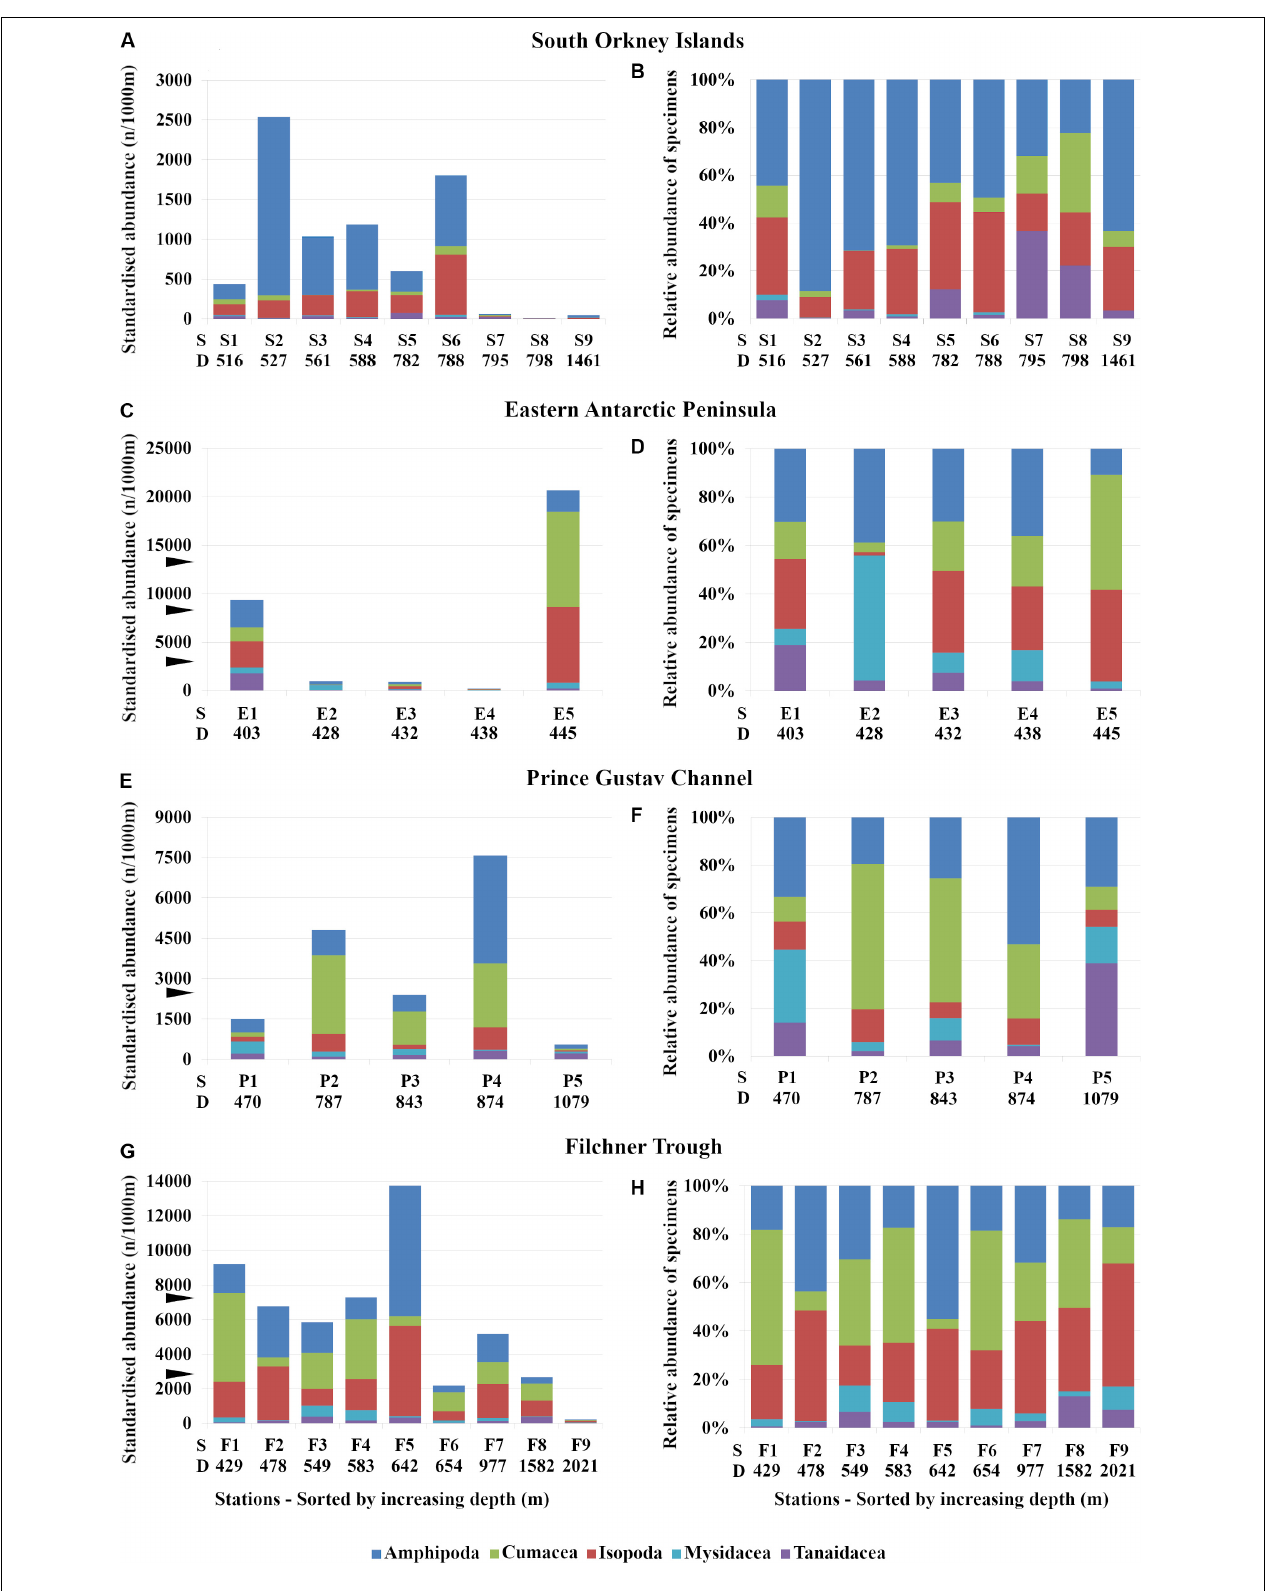
FIGURE 3 | Standard (A,C,E,G) and relative abundance (B,D,F,H) of peracarid orders in the study areas. (A,B) South Orkney Islands, (C,D) Eastern Antarctic Peninsula, (E,F) Prince Gustav Channel, (G,H) Filchner Trough. (cid:73) , maximum standardized abundance at comparative regions; S, station number; D, depth (m).